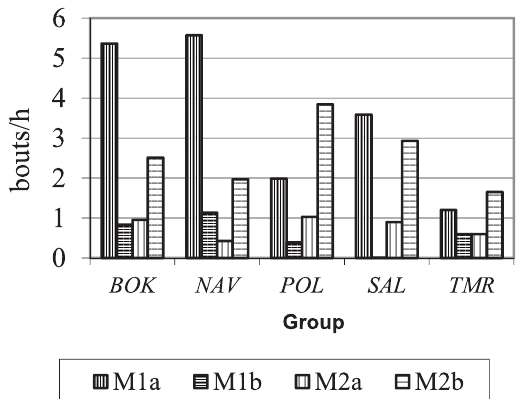
Figure 11. Guarding (bouts/h) by M guarding and b. the first day of incubation, in groups BOK, NAV, POL, SAL and